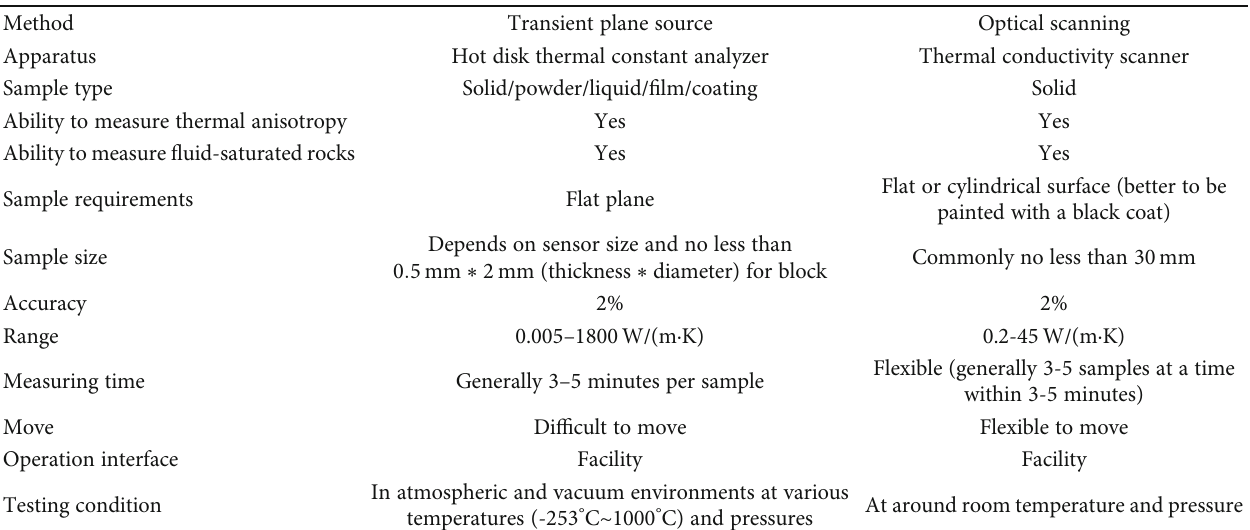
Table 2: Comparison between TPS and OS methods.